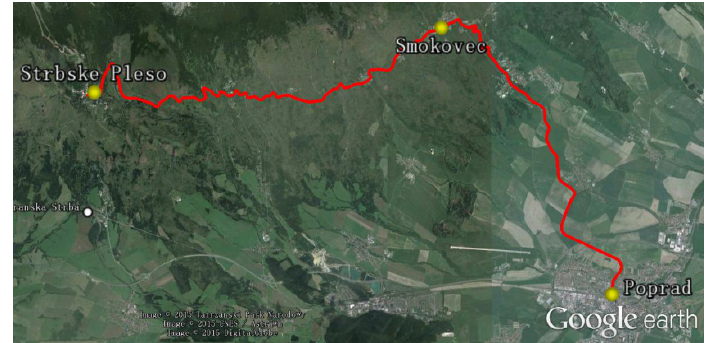
Figure 8. Map of the field data.